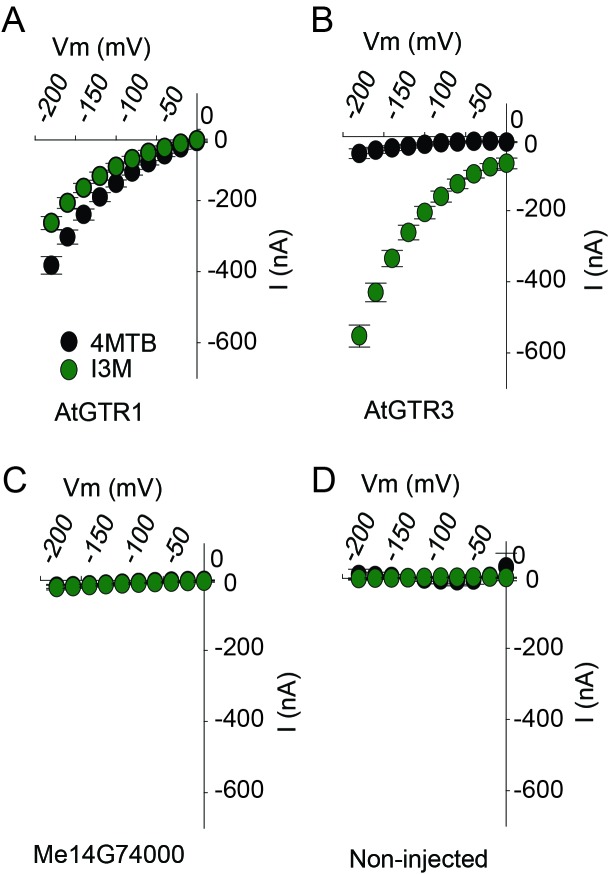
TEVC electrophysiology measurements of AtGTR1, AtGTR3 and Me15G74000.(A–D) 4MTB (black circles)- and I3M (green circles)-induced currents in oocytes expressing GTR homologs that showed glucosinolate uptake in Figure 5B. Expressing and non-expressing oocytes were exposed to 0.2 mM 4MTB or I3M and induced currents were measured at membrane potentials between 0 mV and −180 mV in 20 mV increments at pH5 (Error bars represent ± s.d. of mean for data obtained from four different oocytes per experiment, experiment repeated two times).